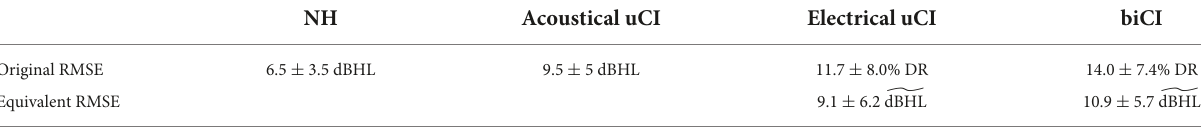
TABLE 3 Root mean square error (RMSE) and standard deviation for the different listeners